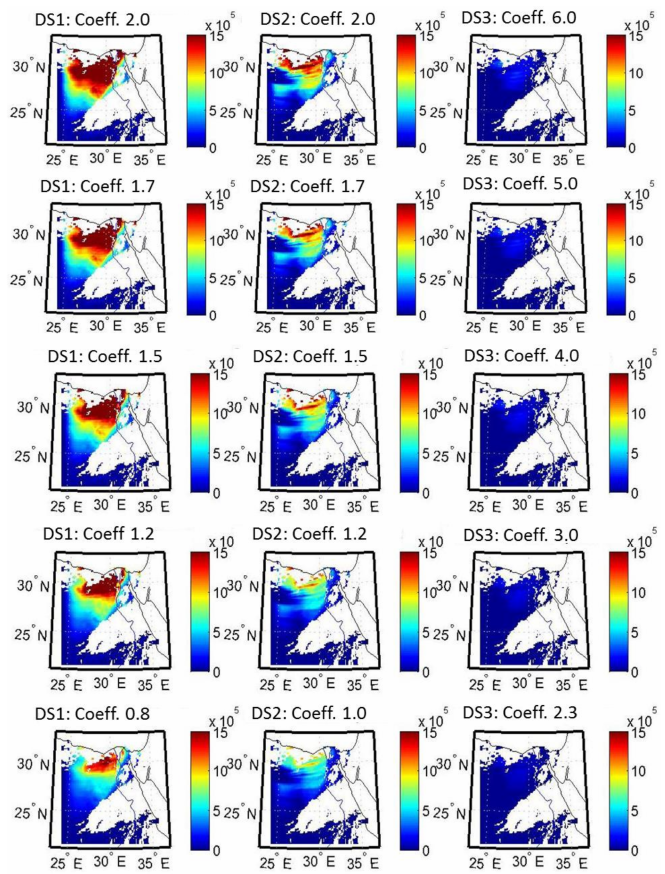
Figure 3. Spatial distribution of dust load over Egypt ( µ g/m 2 ) for the dust storm event of January 2004. The three columns represent the three dust schemes (DS) and each row includes output from using the given coefficient. White areas are pixels not covered by Moderate-resolution Imaging Spectroradiometer Aerosol Optical Depth (MODIS AOD) data. Atmosphere 2018 , 9 , x FOR PEER REVIEW